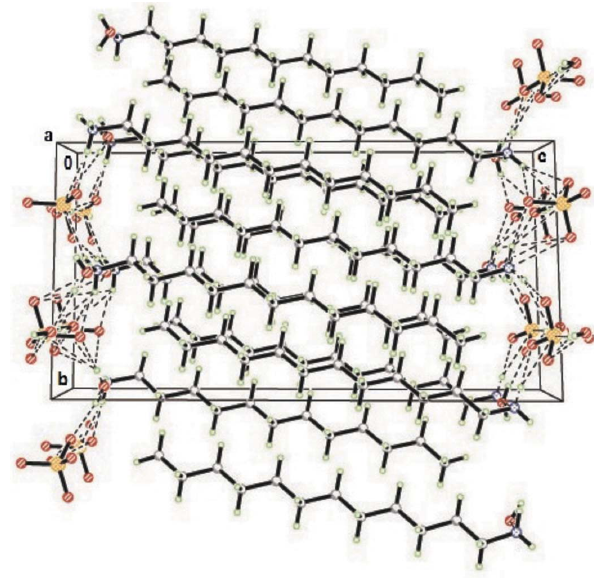
Figure 3 A packing diagram of the title compound, showing the hydrogen-bonded network (dashed lines).